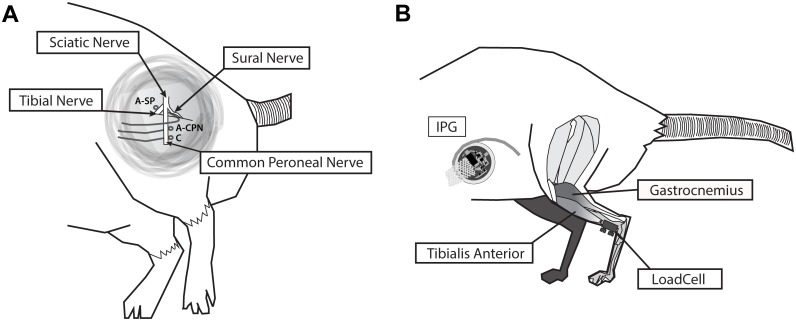
Schematic of the experimental setup.A) Electrode placement for the isolated stimulation of the common peroneal nerve [Anode: A-CPN, Cathode: C] and SpillOver stimulation of common peroneal and tibial nerve [Anode: A-SP, Cathode: C]. B) Position of the in-line loadcell used to measure tensile forces acting on the tibialis anterior muscle. Illustration to approximate scale of the implanted pulse generator (IPG) used for electrical stimulation during the high-intensity-resistance training.